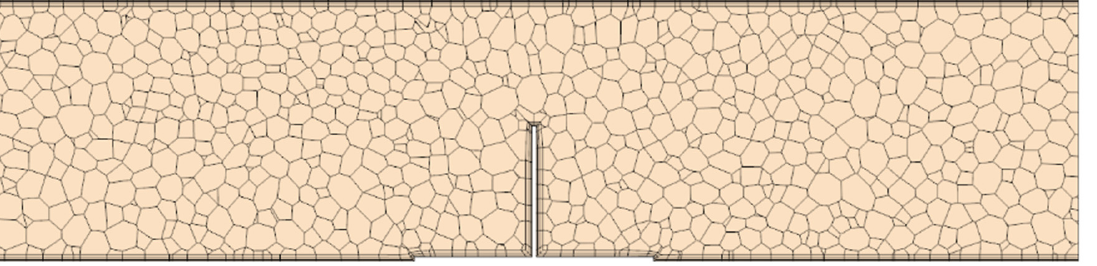
Figure 3. Mesh in horizontal cross-section through air gap.